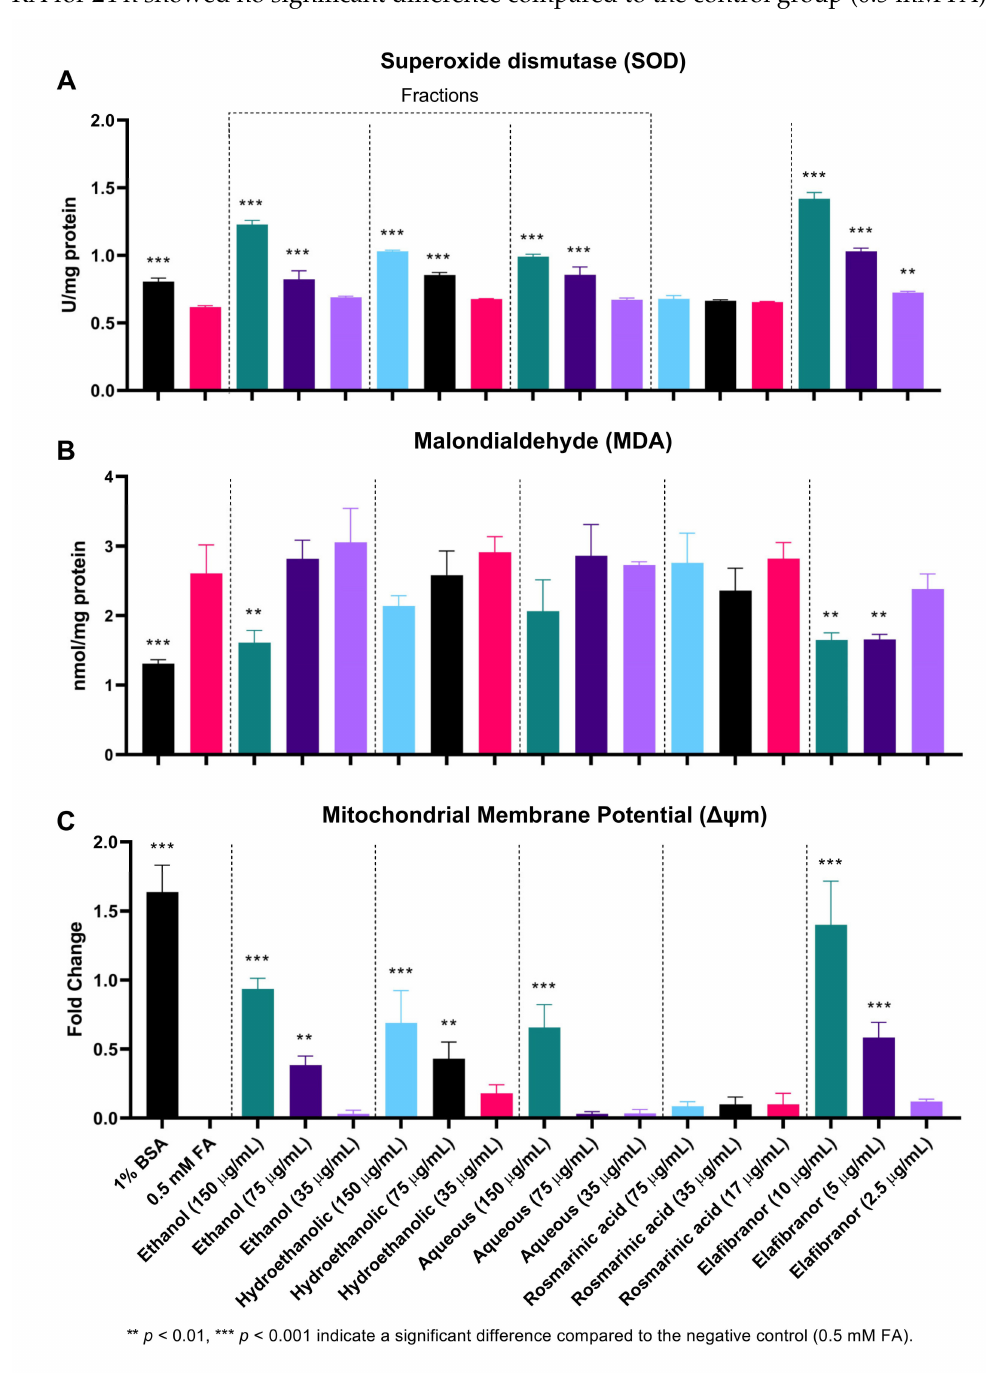
Figure 11. The effect of O. aristatus fractions on the antioxidant enzyme superoxide dismutase (SOD) ( A ), Malondialdehyde (MDA) ( B ), and the mitochondrial membrane potential (MMP) ( C ). Values were presented as mean ± SD, n =